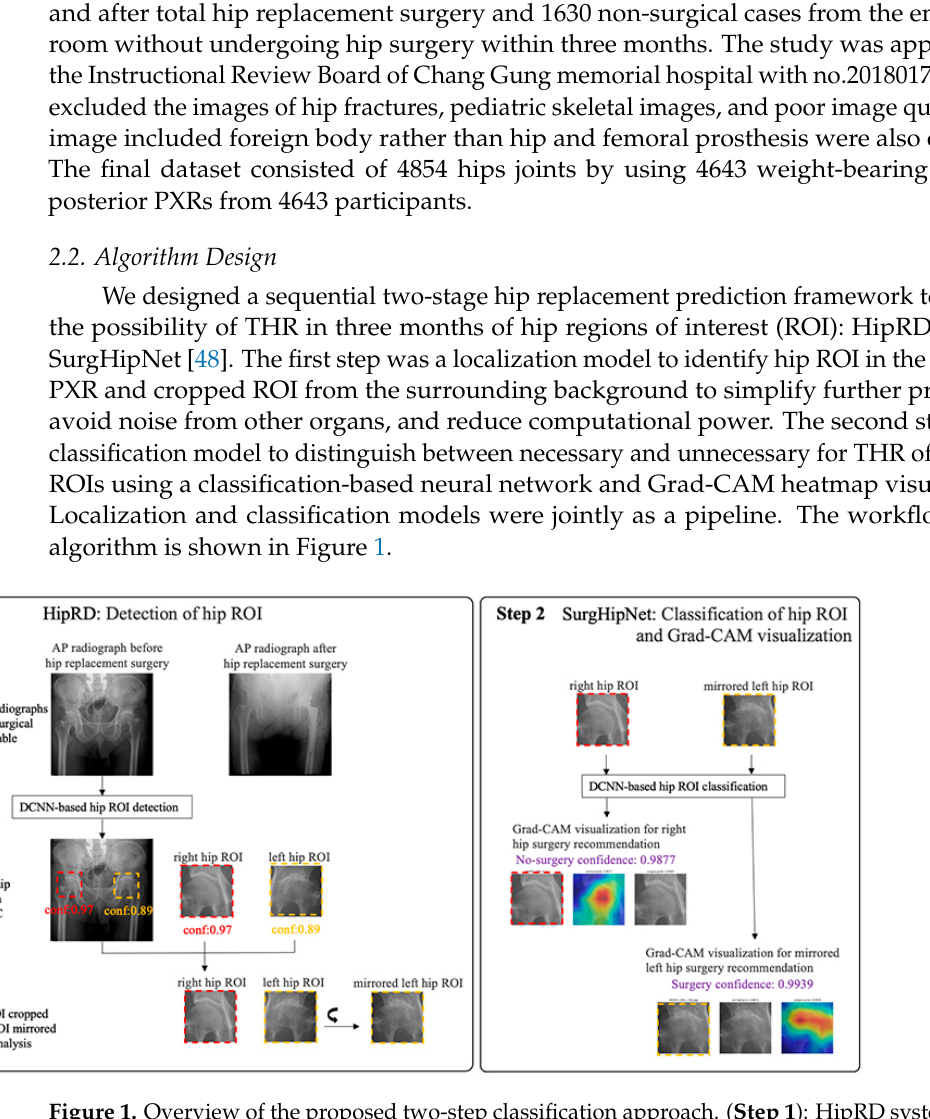
Figure 1. Overview of the proposed two-step classification approach. ( Step 1 ): HipRD system detects hip ROI in the provided AP pelvic radiograph. ( Step 2 ): SurgHipNet classifies hip ROI and provides Grad-CAM visualization for surgery recommendation. ROI: Region of interest.